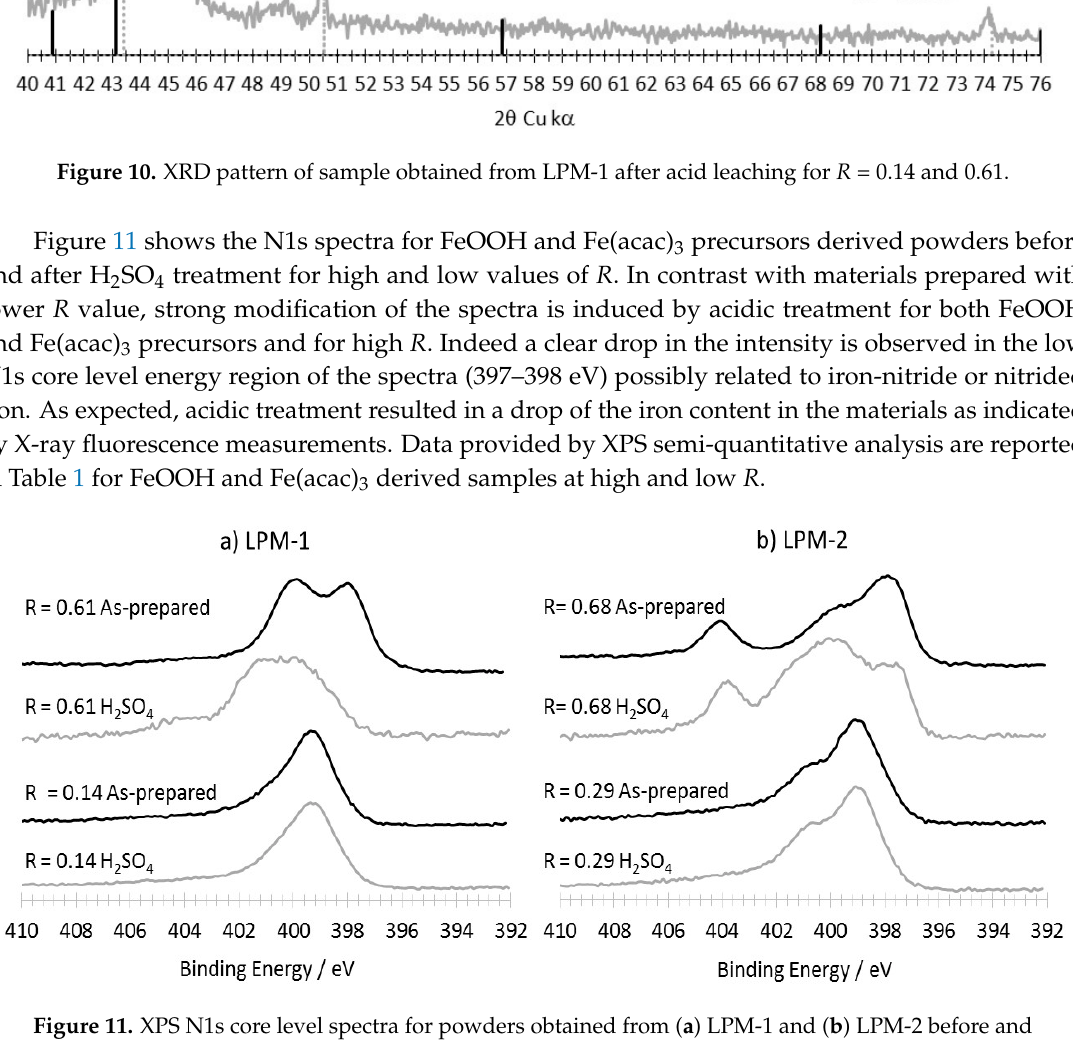
Figure 11. XPS N1s core level spectra for powders obtained from ( a ) LPM-1 and ( b ) LPM-2 before and after H 2 SO 4 treatment, for low and high R values. Intensities are normalized.